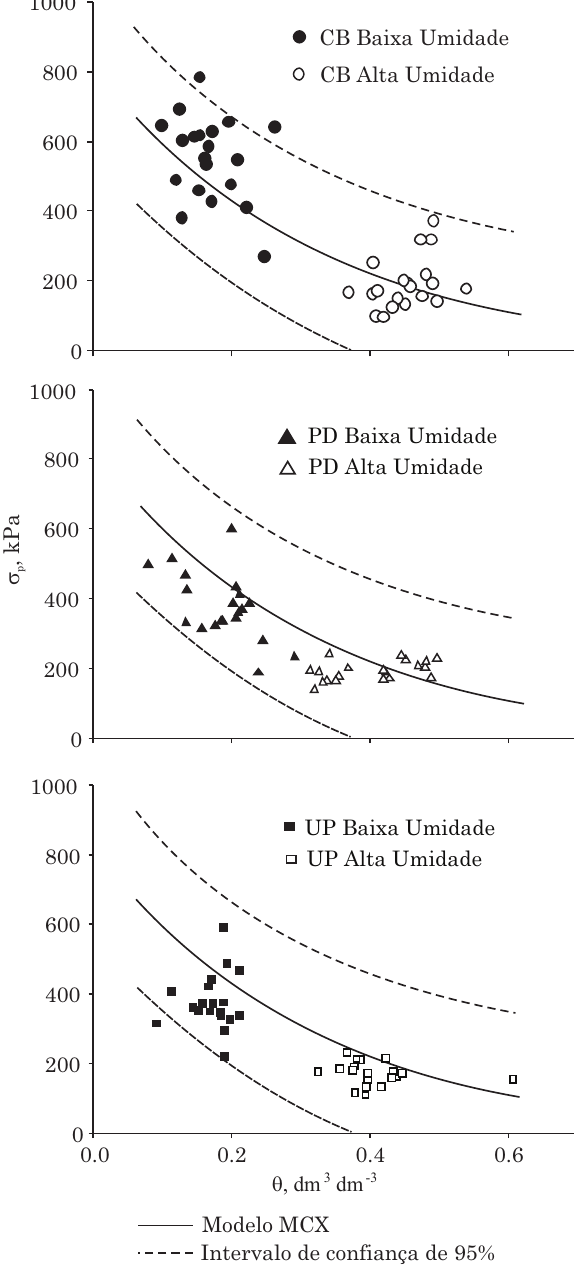
Figura 6. Modelos de capacidade de suporte de carga descrevendo o impacto dos três usos analisados em Cambissolo Háplico, com amostras equilibradas em alta e baixa